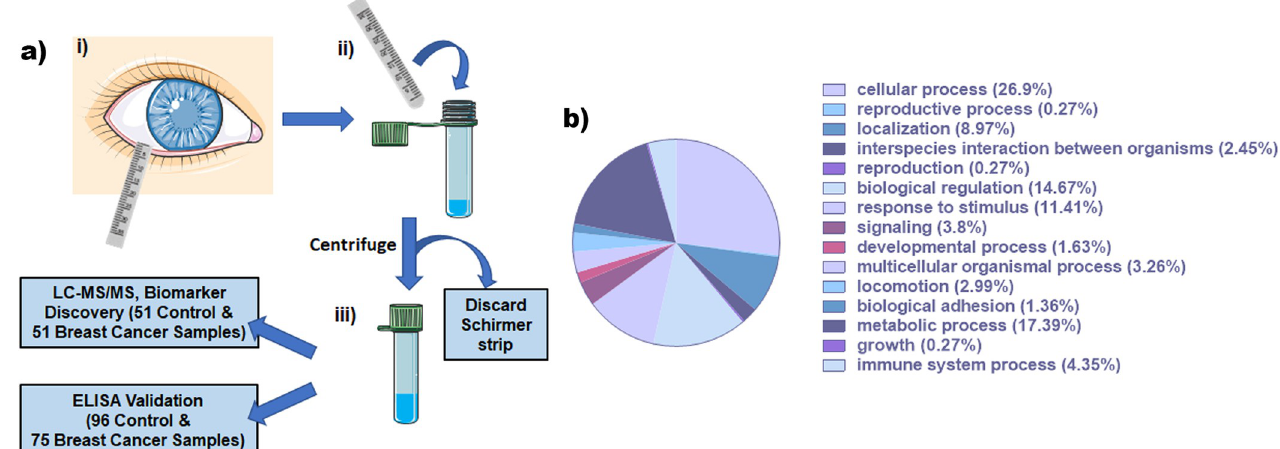
Fig 1. a) Schematic of Tear Collection using Schirmer strip- i) Schirmer strip is placed in the lower conjunctival fornix; ii) wetted strips are placed in screw-top tube prefilled with 225 μ L of 1XPBS and centrifuged to collect the tears; iii) Schirmer Strips are discarded to collect tears and stored in -80˚C before being analyzed by LC-MS/MS and validated by ELISA. b) Functional classification of 301 mapped proteins in tear samples using PANTHER classification